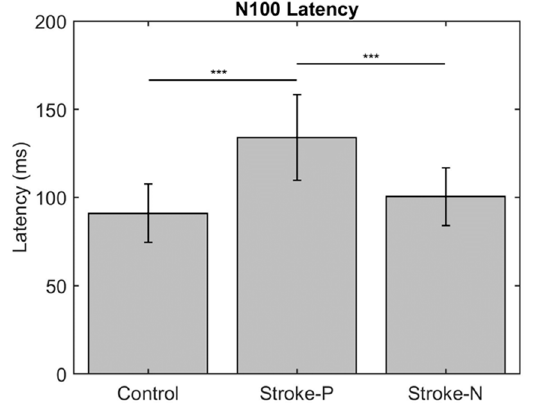
Figure 4. Latency of contralateral (to stimulated hand) Somatosensory Evoked Potential (SEP) com- ponent P50. Stars indicate statistically significant differences between groups (control, stroke paretic hand (Stroke-P) and stroke non-paretic hand (Stroke-N)) ** < 0.01 *** < 0.001.